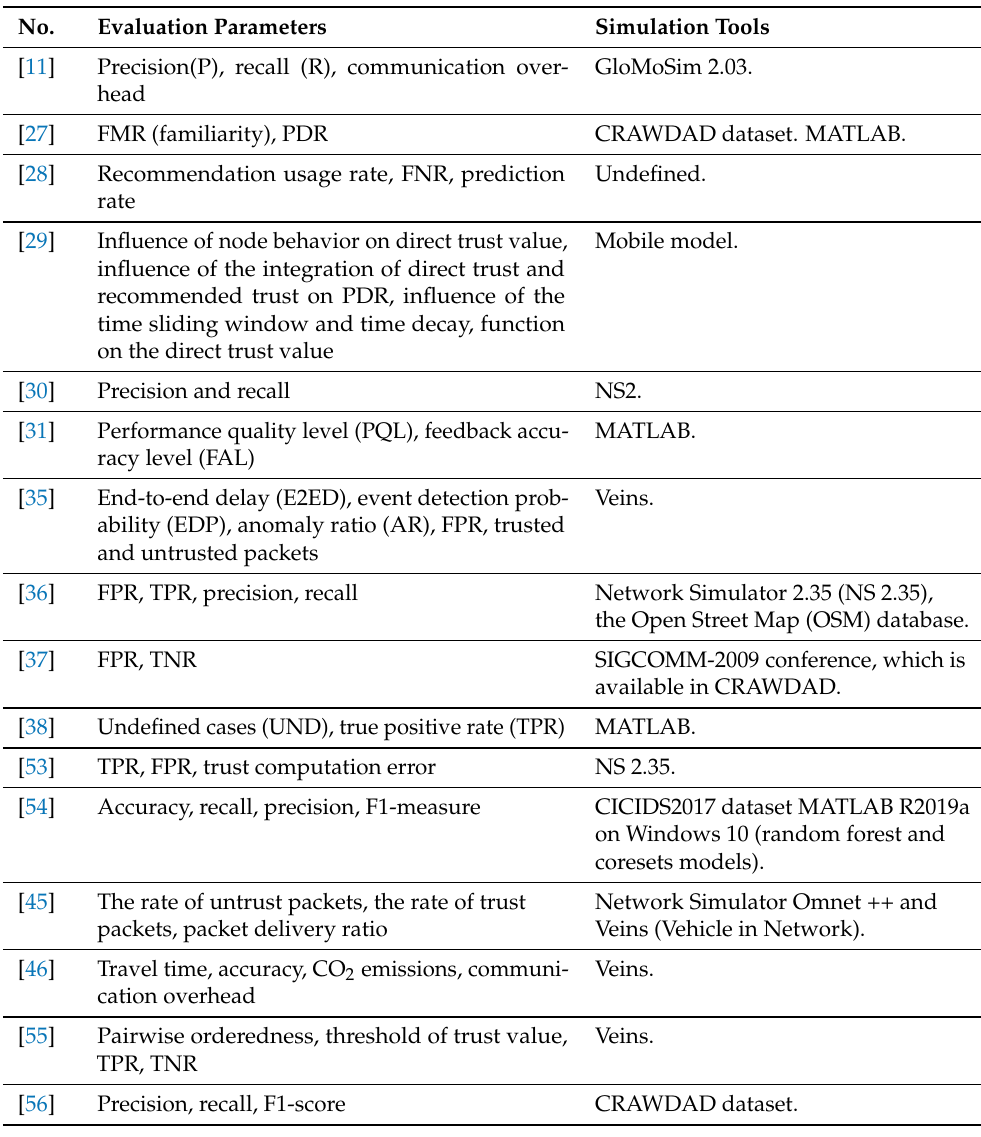
Table 4. Existing evaluation parameters and simulation